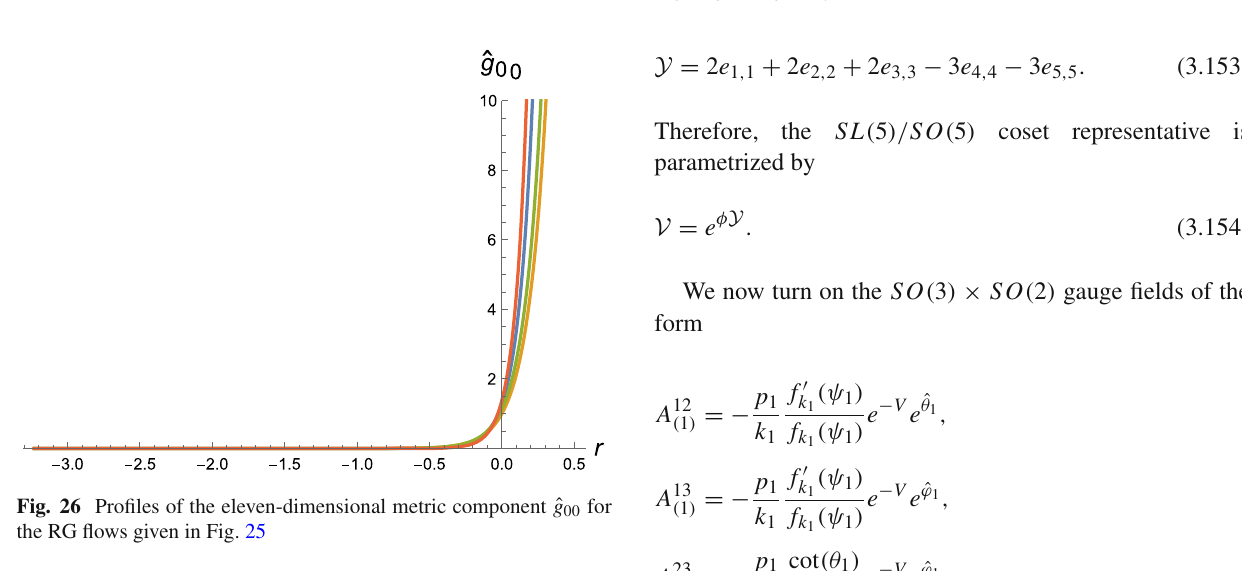
Fig. 25 RG flows from the N = 4 AdS 7 critical point to the AdS 3 × CH 2 fixed point and curved domain walls for SO ( 2 ) × SO ( 2 ) twist in SO ( 5 ) gauge group. The blue, orange, green and red curves refer to p 2 = − 1